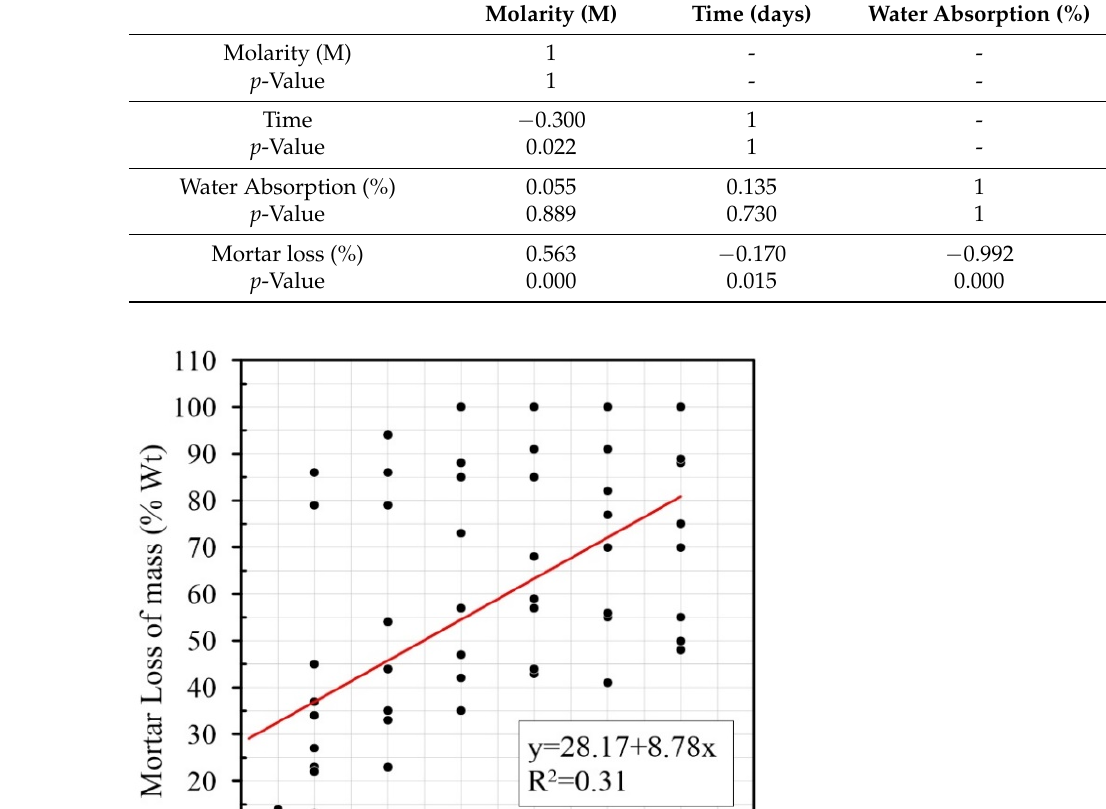
Table 4. Pearson correlation for RCA treated with H 2 SO 4 .